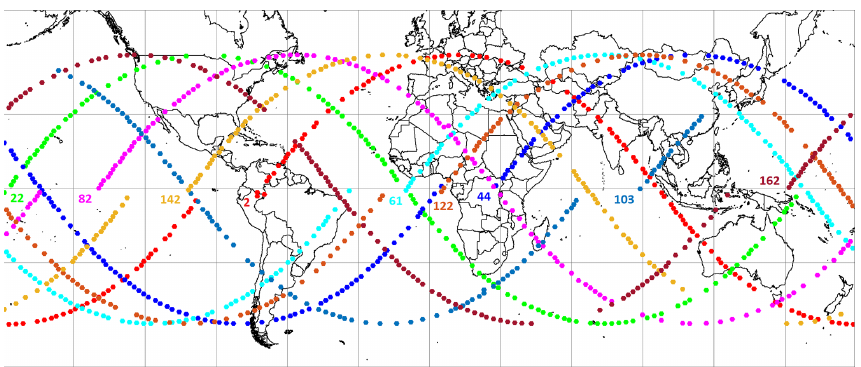
Figure 5. Spatial coverage of Kosmos-49 data. The projection of approximately every 20th orbit on the Earth’s surface is shown. Dots indicate the locations of